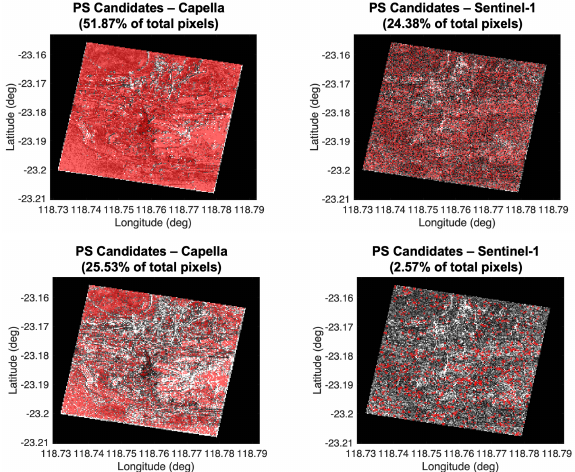
Figure 6. Comparison between Capella and Sentinel image stacks with an SCR threshold of > 2 (top) and > 10 (bottom). The number in parentheses indicates the percentage of total pixels identified as PS